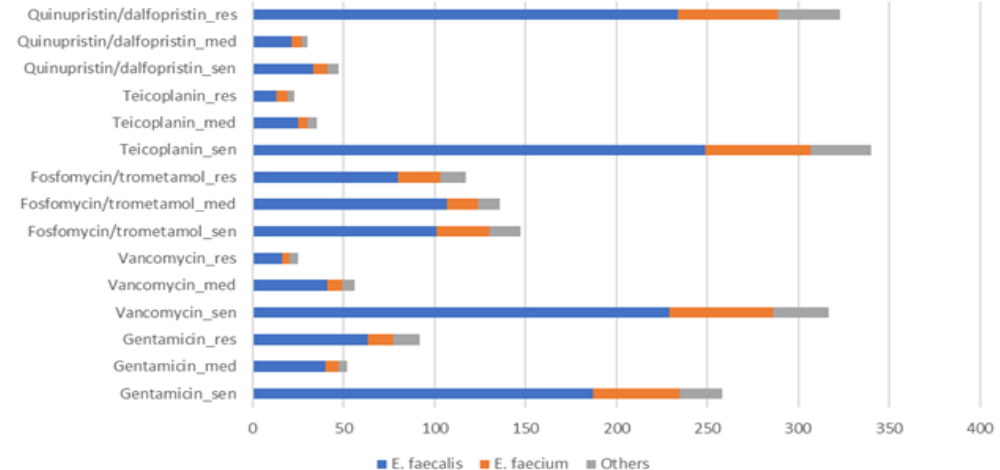
Fig. 2. Enterococcus species and their resistance to five different antibiotics. A suffix of "sen" means sensitive to that antibiotic, "med" mean intermediate resistance, and "res" means resistant.